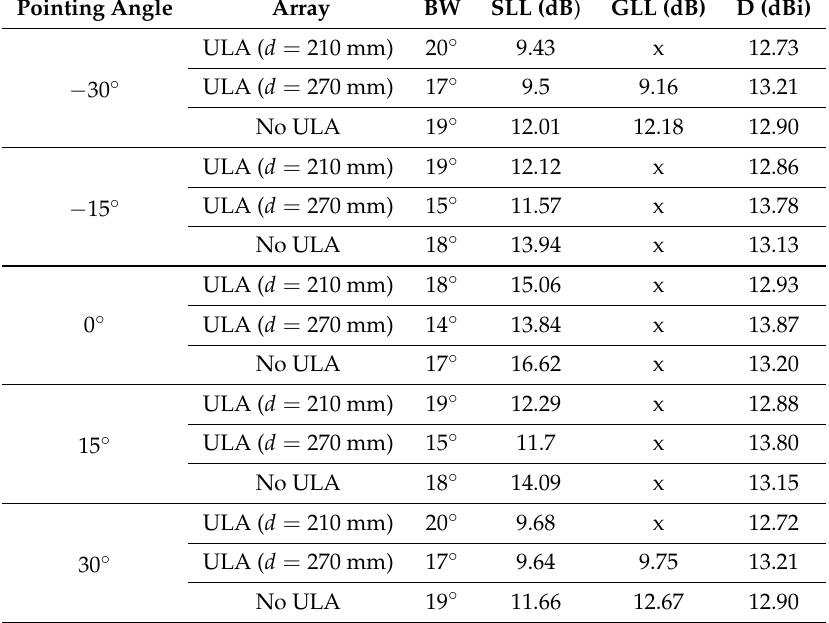
Table 2. Main characteristics of azimuth plane radiation patterns using conventional weighting of the ULAs with inter-element distances of 210 mm and 270 mm, and a Non-ULA (NULA) with N = 5 elements. The considered steering angles are φ = [ − 30 ◦ , − 15 ◦ ,0 ◦ ,15 ◦ ,30 ◦ ] . SLL, Sidelobe Level; BW, Bandwidth; GLL, Grating Lobe Level. Pointing Angle Array BW SLL (dB ) GLL (dB) D